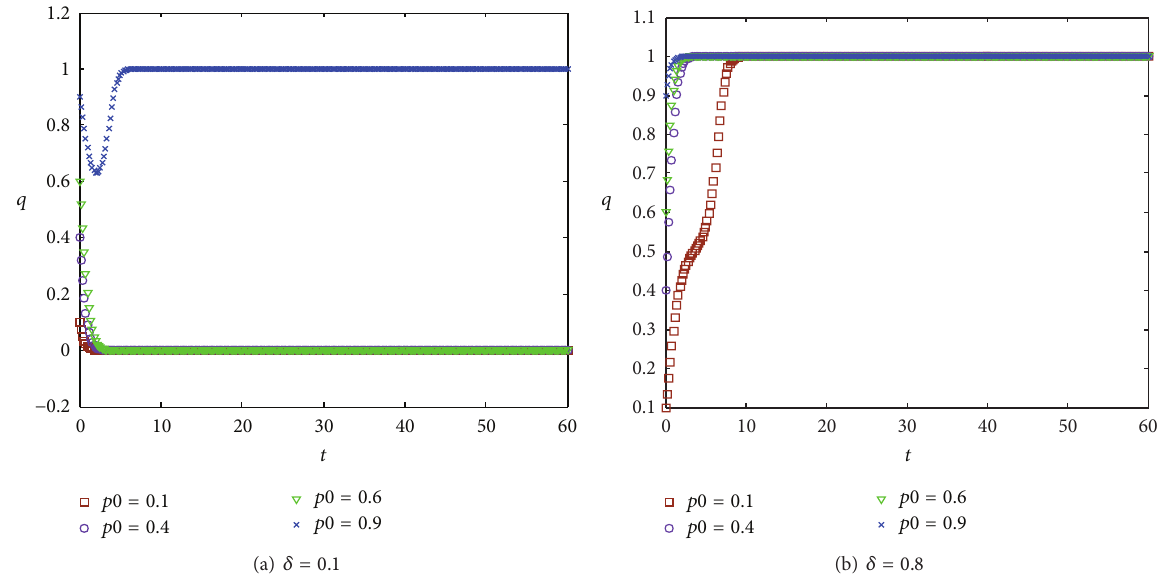
Figure 5: The influence of the government’s supervision efficiency on the cooperation